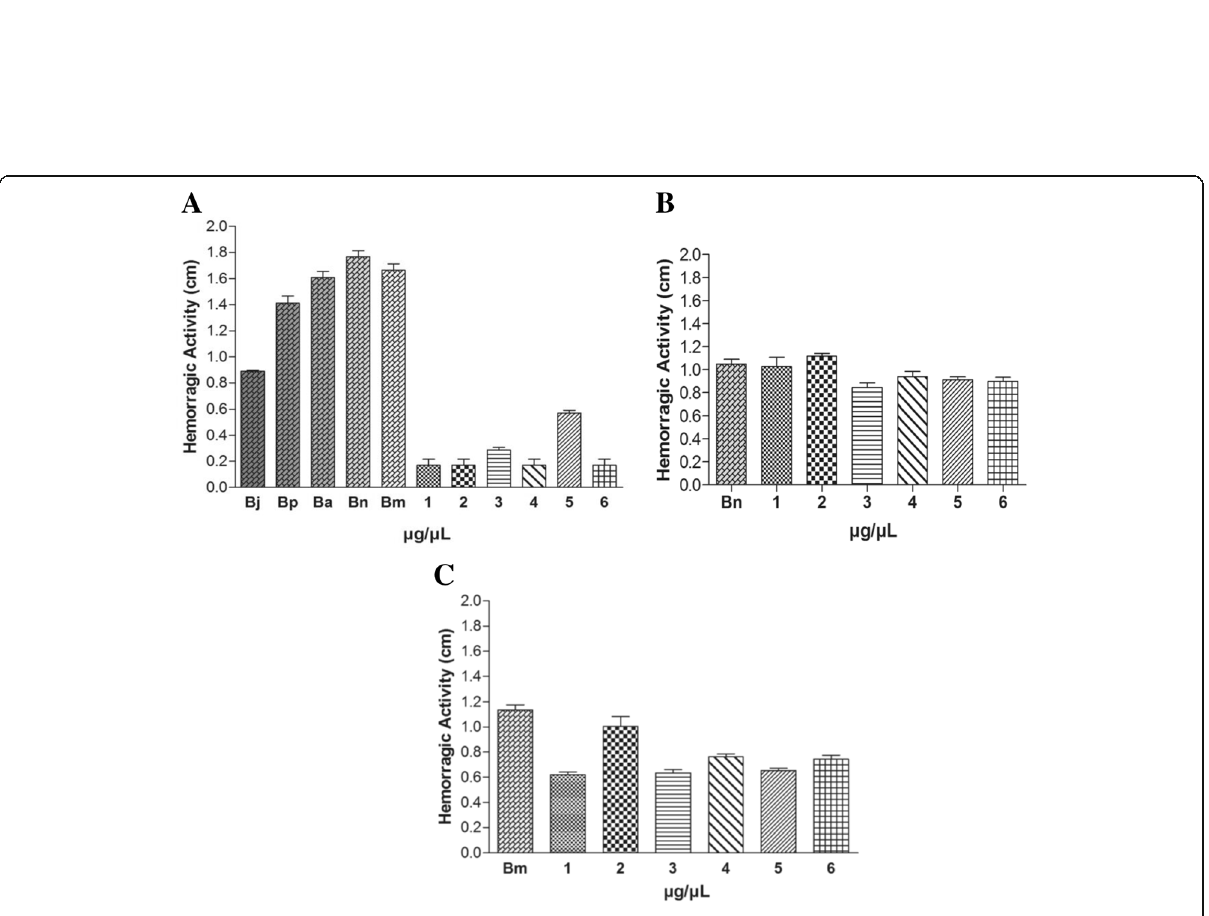
Fig. 3 Hemolytic activity of cnidarian extracts. (1) C. gigantea (body-wall), (2) C. gigantea (total), (3) M. alcicornis, (4) S. helianthus, (5) P. homomalla and (6) B. annulata. ( a ) Percentage of hemolytic activity tested at different doses from 50 to 2000 μ g; ( b ) the hemolysis was tested at the same 200 μ g/mL